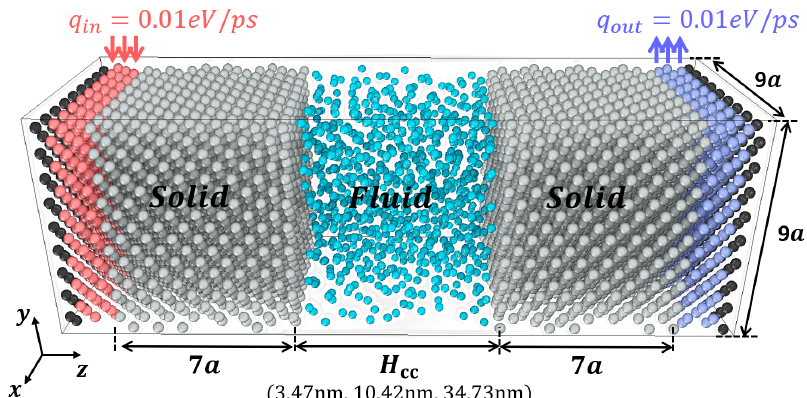
Figure 2. A systematic detail of heat transfer molecular dynamics (MD) simulation. The fluid molecules are confined between two solid blocks. The black atoms at the outmost solid layer are fixed. The second to forth outmost solid layer marked with red and blue color represent thermostated atoms. H cc is center-to-center distance. The solid blocks have a width of seven lattice constants except for the thermostated layers and nine lattice constants along x and y directions.